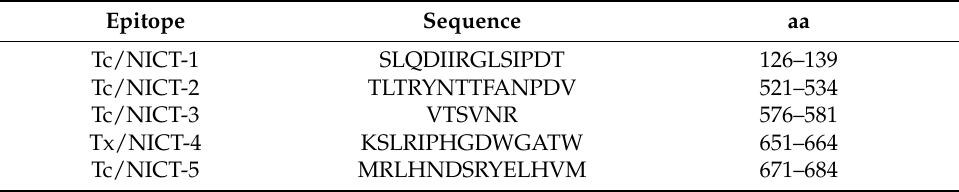
Table 1. Epitopes mapped in the Trypanosoma cruzi NICT-like protein (Q4DEM3) using a pool of sera from patients with chronic Chagas